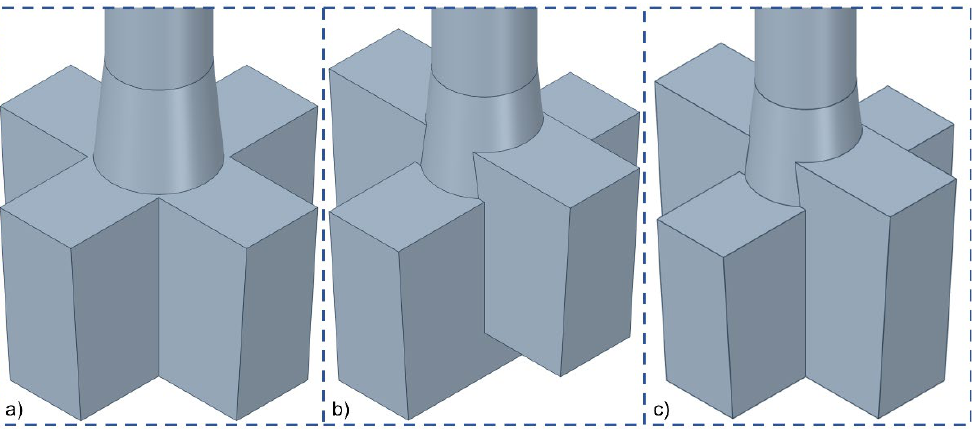
Figure 1. Schematic diagram of three blade types. ( a ) Impeller model 1, ( b ) Impeller model 2, ( c ) Impeller model 3. Table 1. Geometric and physical parameters adopted in the numerical